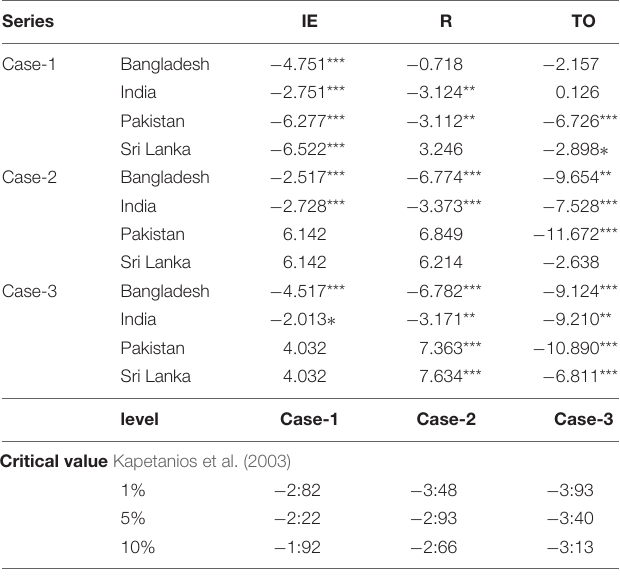
TABLE 3 | Results of KSS non-linear unit root test.